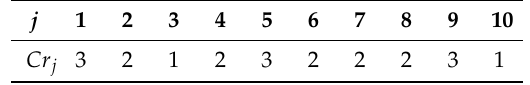
Table 5. The remanufacturing cost of components at level